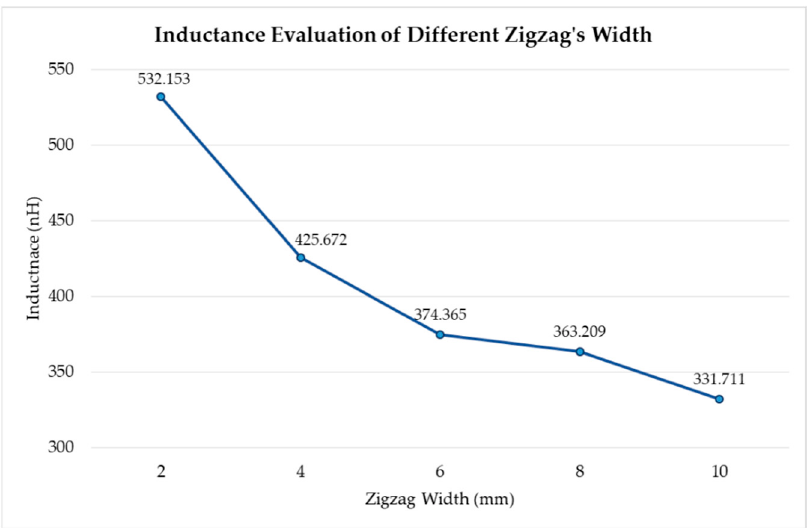
Figure 2. Inductance vs. zigzag width. Inductance values simulated in Ansys for a single-loop inductive sensor with changing the zigzag width.